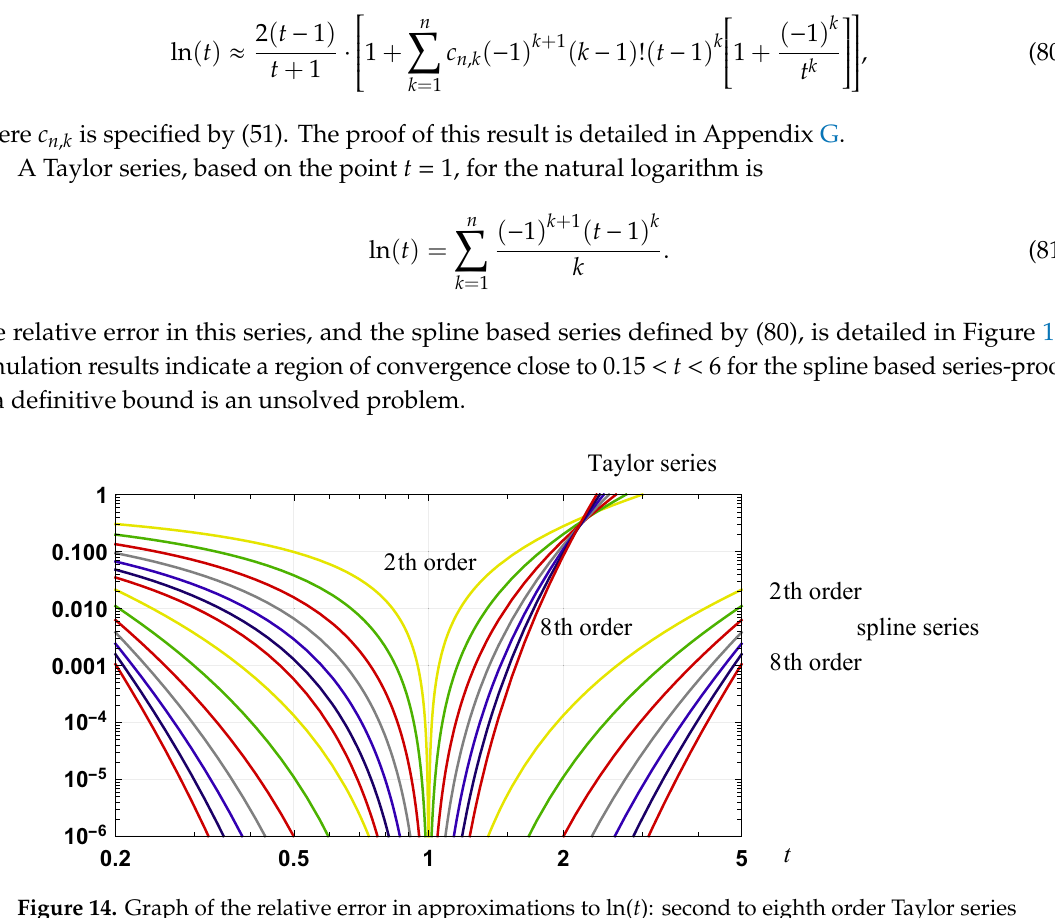
Figure 14. Graph of the relative error in approximations to ln( t ): second to eighth order Taylor series and spline based series approximation.